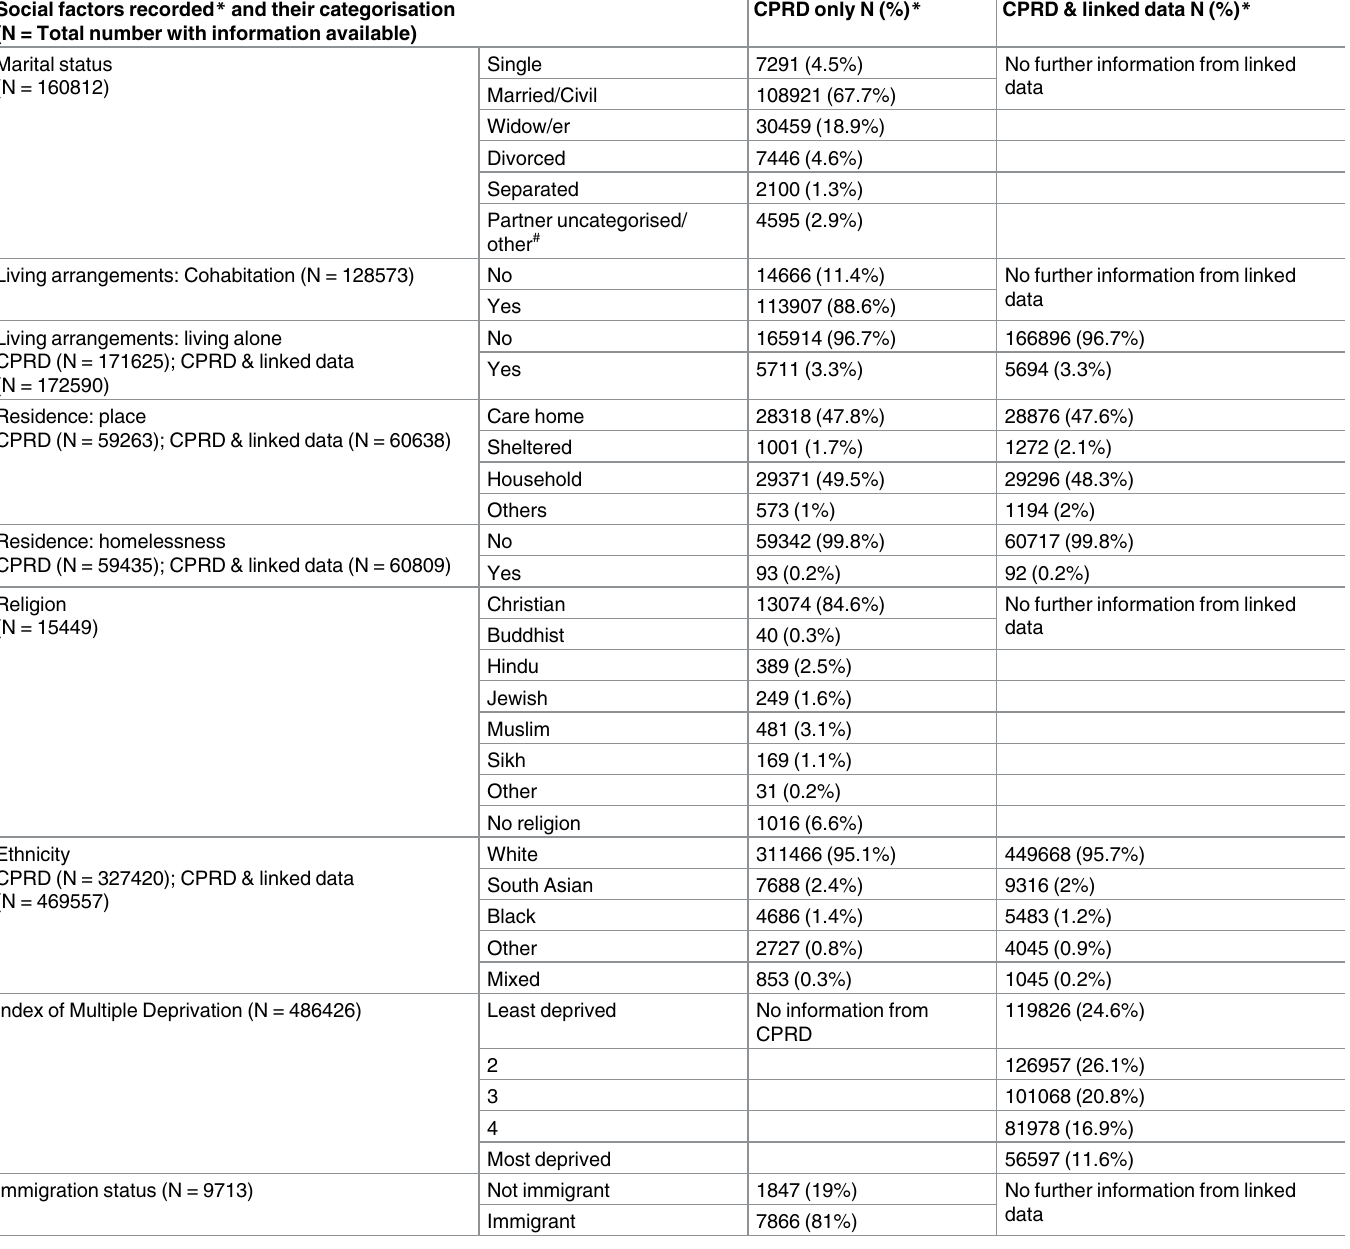
Table 2. Social factors in Clinical Practice ResearchDatalink: Recording and categorisation. Social factors recorded * and their categorisation (N = Total number with information